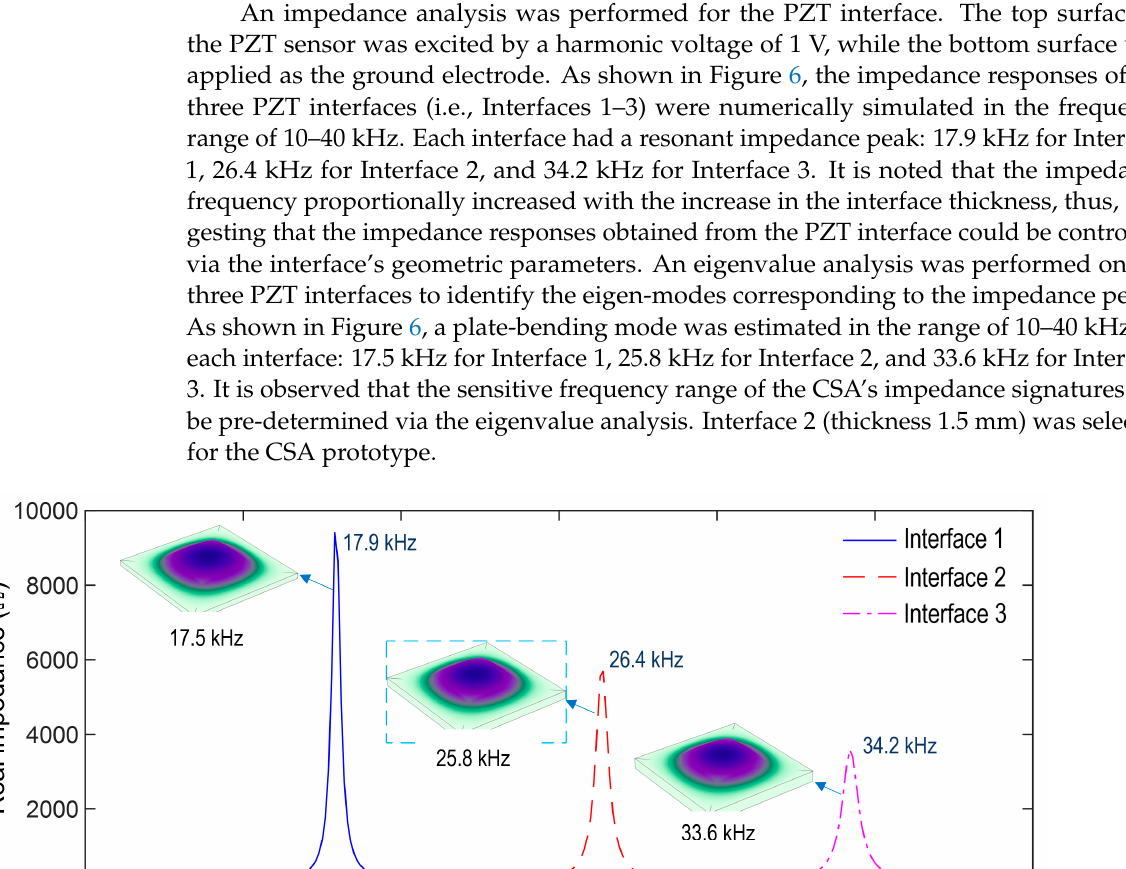
Figure 7. FE model of CSA under compression (dimension in mm). To investigate the effect of the different loading directions, the CSA was assigned with compressive forces in both the z- and x-directions (see Figure 7). Seven loading sce- narios (P1-P7) of the compressive forces were simulated to acquire the impedance signa- tures of the CSA (see Figures 8 and 9). A sequence of applied forces was listed as follows: P1 (1.5 kN), P2 (1.75 kN), P3 (2.0 kN), P4 (2.25 kN), P5 (2.5 kN), P6 (2.75 kN), and P7 (3.0 kN). The CSA’s impedance signals were analyzed in the frequency range of 10–40 kHz. Figure 8 shows the impedance responses of the CSA under the z- and x-directional load- ings in the range of 10–40 kHz under loading P1. For the CSA under the z-directional loading, there was only one prominent impedance peak at 23.6 kHz in the simulated range, thus, confirming the pre-determined sensitive frequency range of the CSA using the vibrating plate. For the CSA under the x-directional loading, the main impedance peak